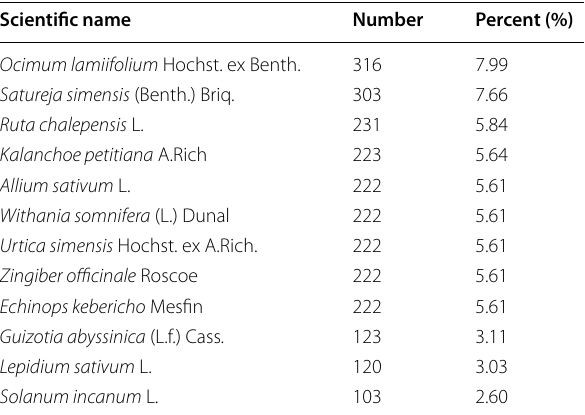
Table 6 List of medicinal plants cited by the highest number